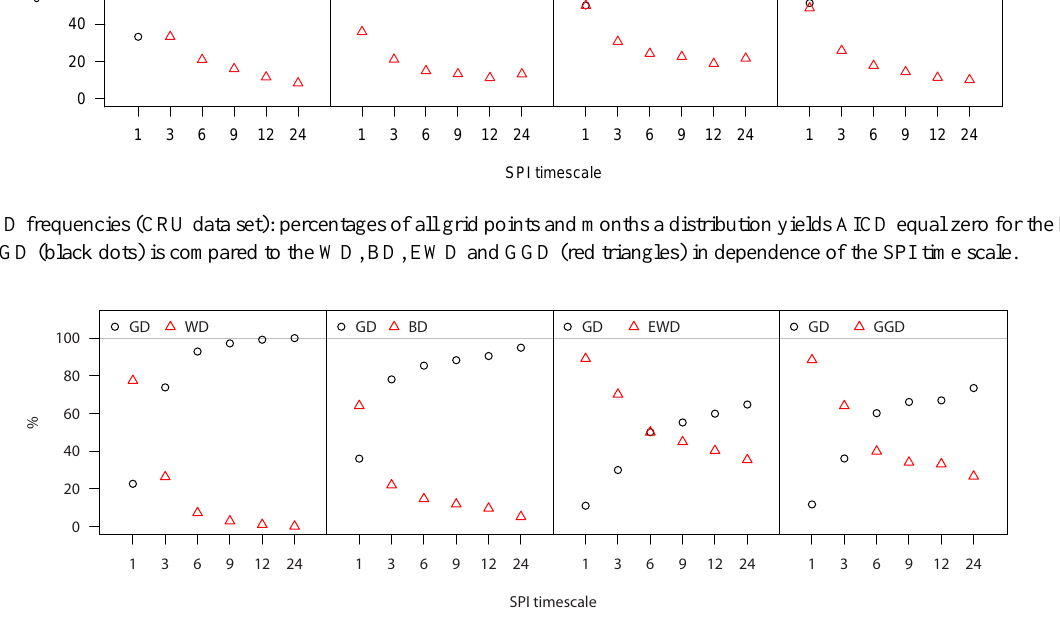
Fig. 13. AICD frequencies (ECHAM5 data set): percentages of all grid points and months a distribution yields AICD equal zero for the